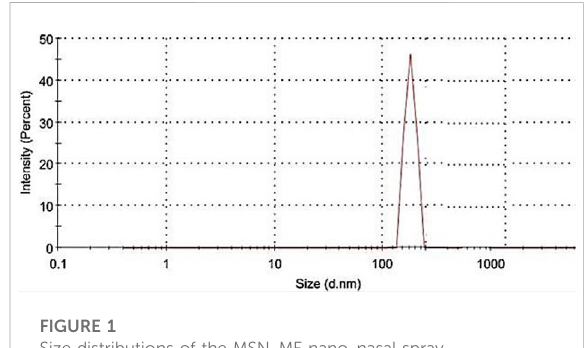
FIGURE 1 Size distributions of the MSN-MF nano-nasal spray.